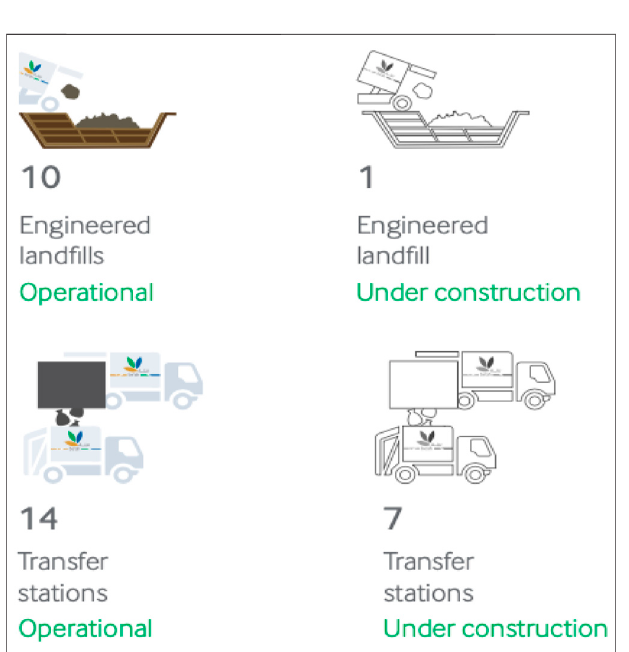
FIGURE5 | Current municipal solid waste infrastructurestatusin Oman.